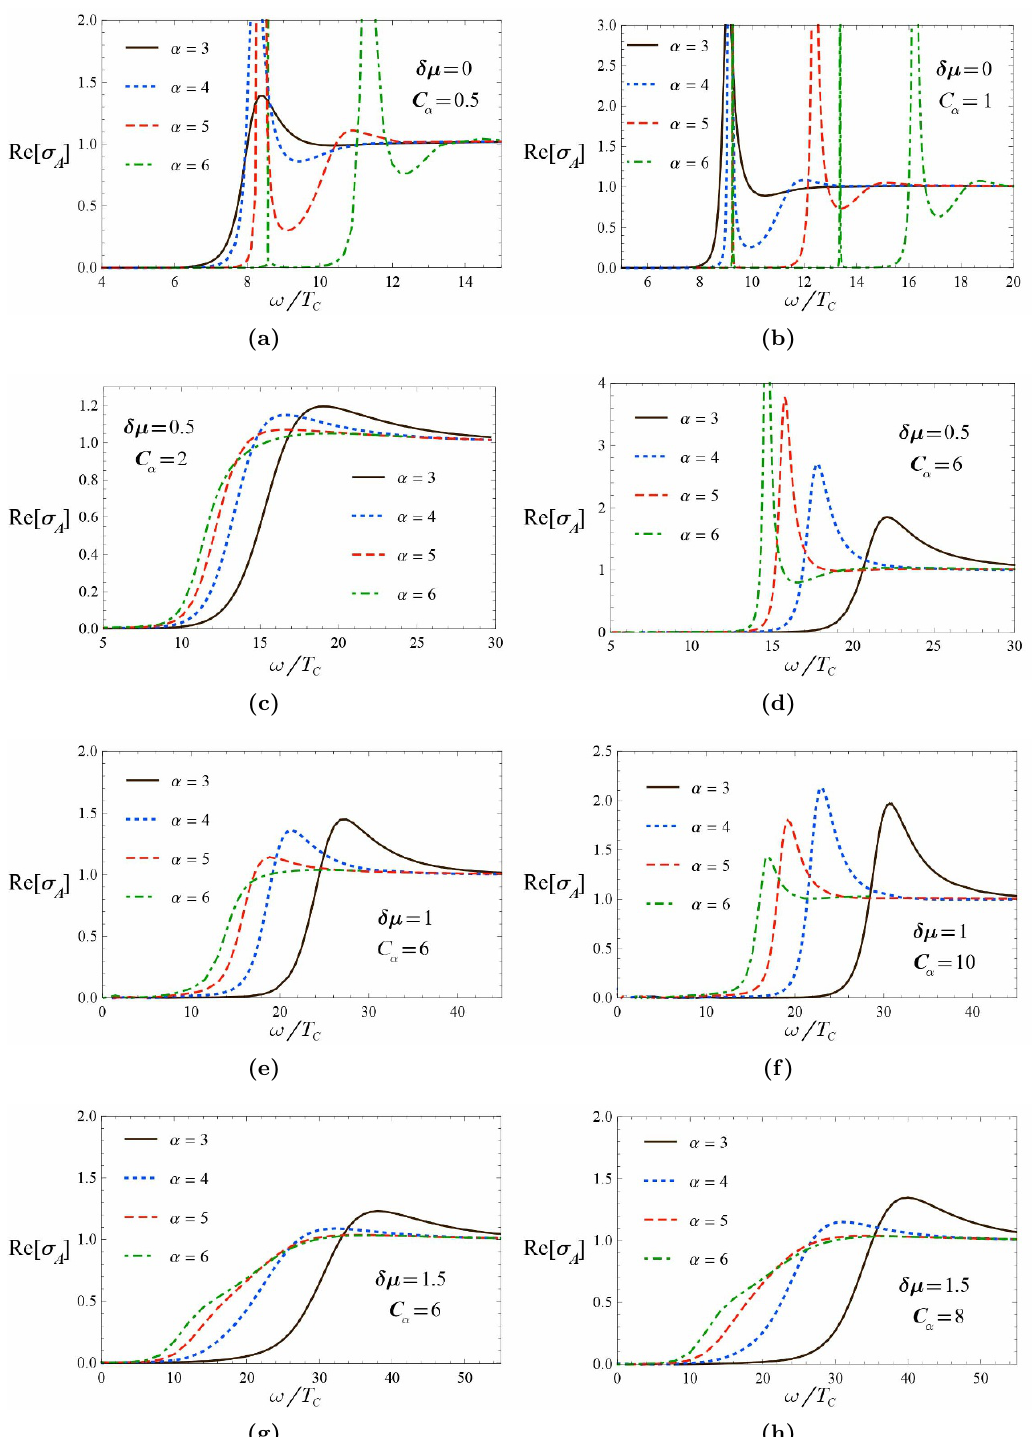
Figure 17. The optical electric conductivities in terms of !=T c for function F ( ) = 2 + C (cid:11) (cid:11) with (cid:11) = 3 ; 4 ; 5 ; 6 (solid curve, dotted curve, dashed curve, and dot-dashed curve). Each row is related to systems with same imbalance; we have (cid:14)(cid:22) = 0 ; 0 : 5 ; 1 ; 1 : 5 from up to down.